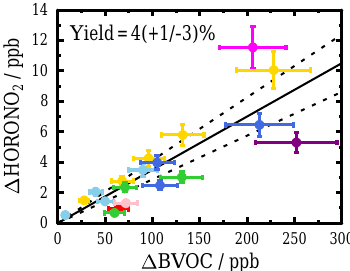
Figure 9. γ -terpinene hydroxy nitrate production ( (cid:49) HORONO 2 ) as a function of the amount of BVOC consumed ( (cid:49) BVOC). Colors represent independent experiments performed on different days. All of the experiments were conducted in the absence of seed aerosol. The error bars and fits are derived as in Fig.